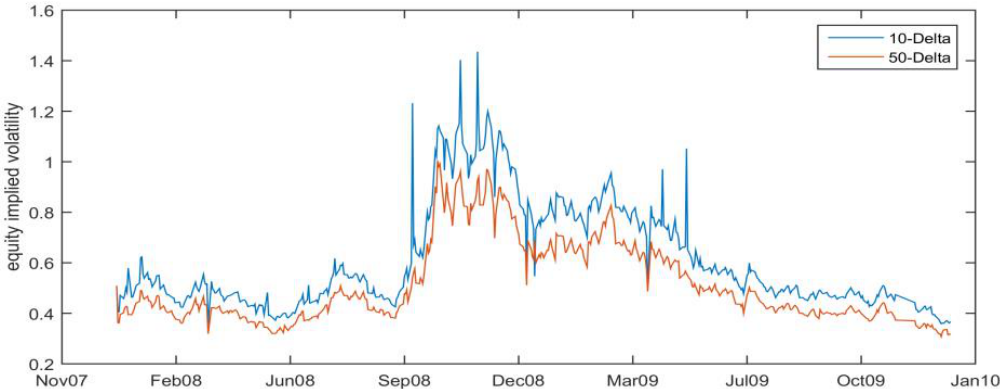
Figure 1. Average 1-month 10-delta versus 50-delta implied equity put volatilities.